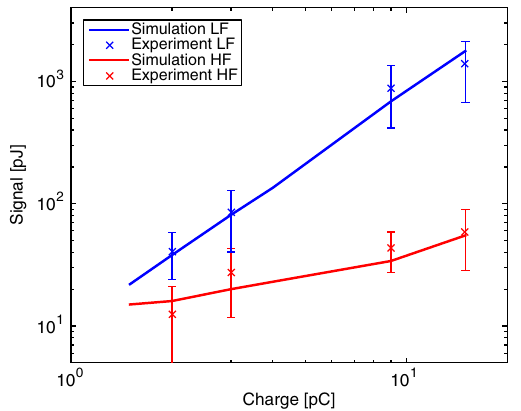
FIG. 11. The simulated energy and the experimental energy (background subtracted) of LF and HF filtered CTR for different beam charges Q